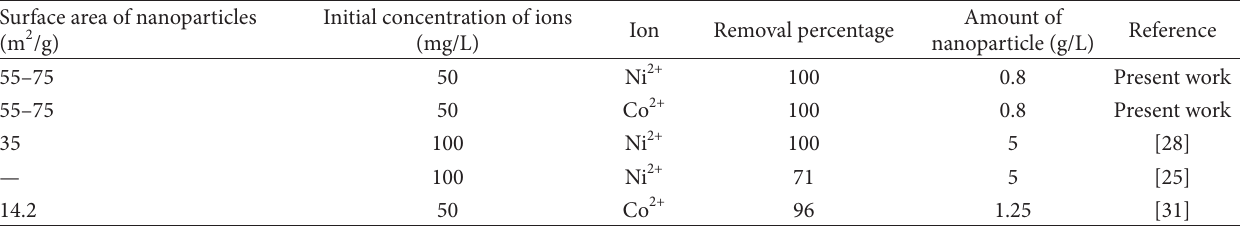
T 3: e removal efficiency of nickel and cobalt ions in solutions containing both ions by applying sonication in optimum times. Initial concentration of Entry Ni 2+